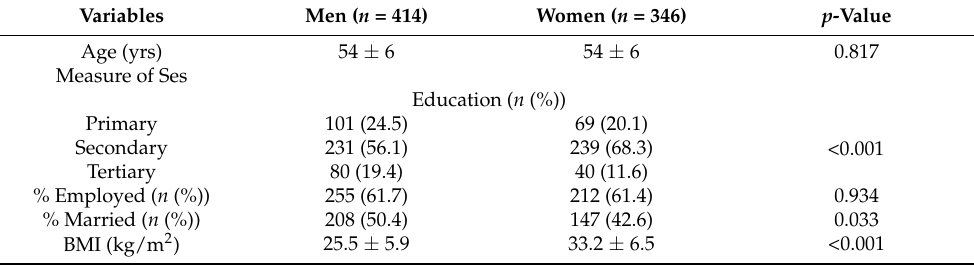
Table 1. Participant